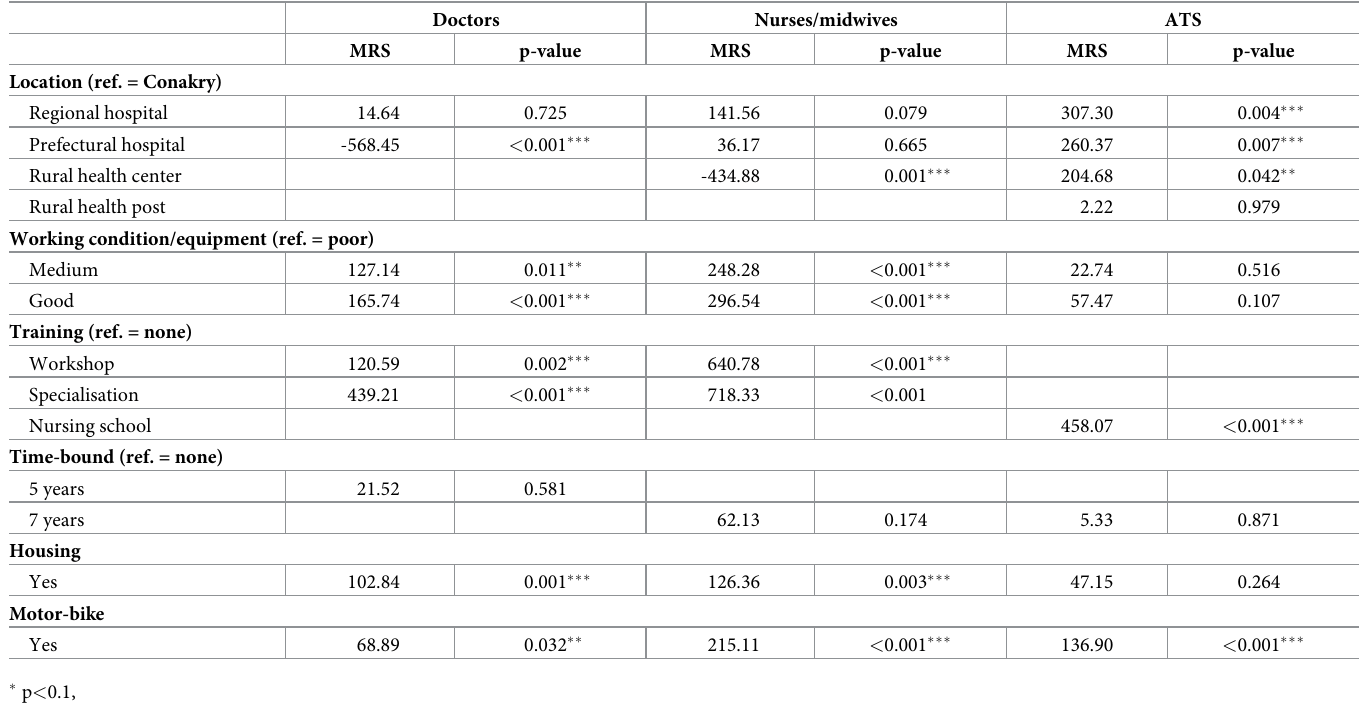
Table 6. MRS: Monetary value in